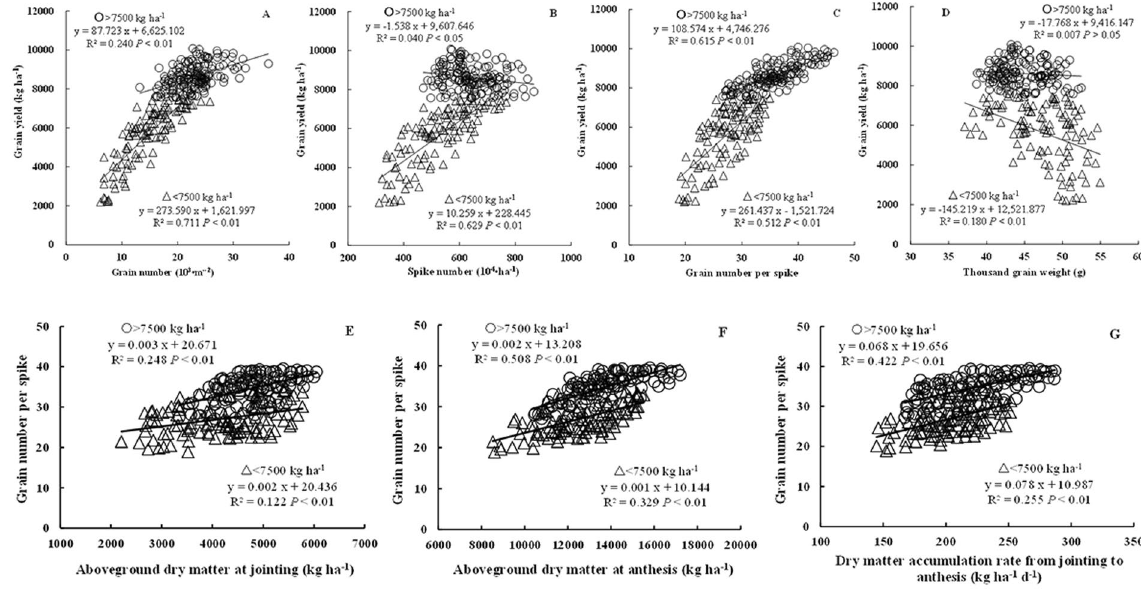
Figure 1. Relationship between grain yield and yield components and relationship between grain number per spike and pre-anthesis dry matter and accumulation rates of aboveground dry matter at different phases before